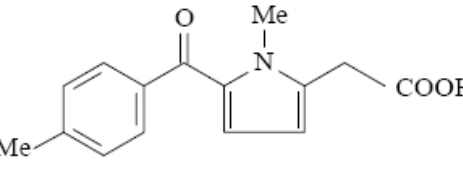
Fig. 1 Structure of tolmetin